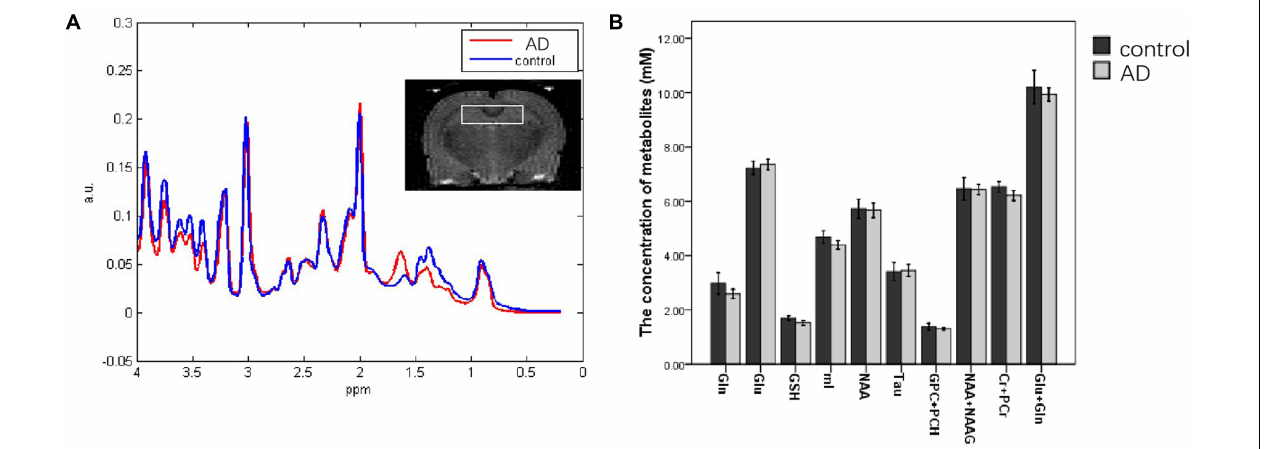
FIGURE 4 | MRS images analyzing the metabolite content in the hippocampi of control and AD rats at 28 days after A β 25–35 administration (A) ; the white box in the rat brain is the volume of interest of MRS scanning. (B) Metabolite concentration in the hippocampus at 28 days after A β 25–35 administration; it showed no difference was found between the two groups (all P > 0.05, error bar was standard error).